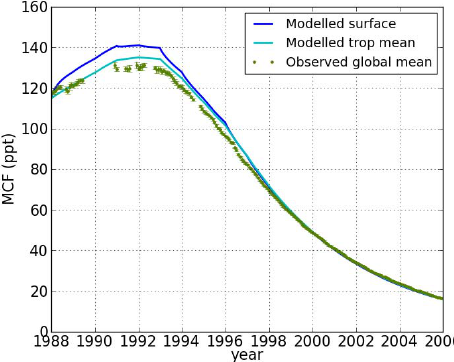
Fig. 3. Observed and modeled evolution of methyl chloroform sur- face and tropospheric mean mixing ratios between 1988 and